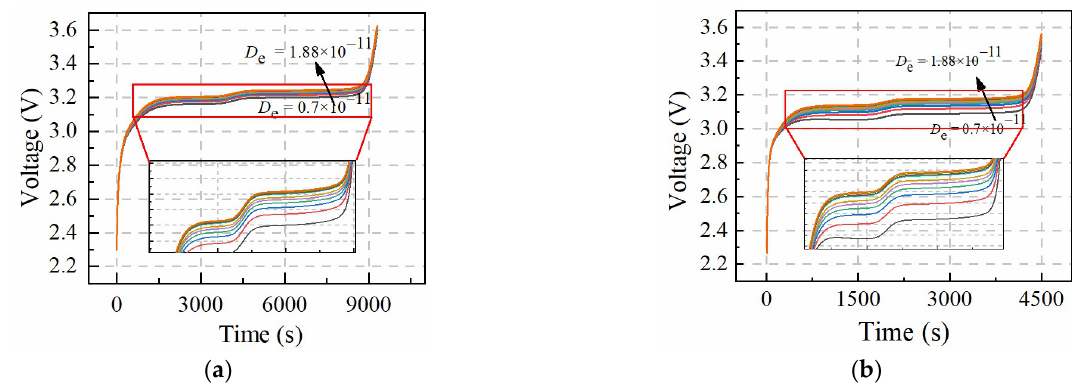
Figure 4. Sensitivity curves of battery terminal voltage to D e under different charging rates. ( a ) Sen- sitivity curves under 0.5 C charging rate; ( b ) Sensitivity curves under 1 C charging rate.